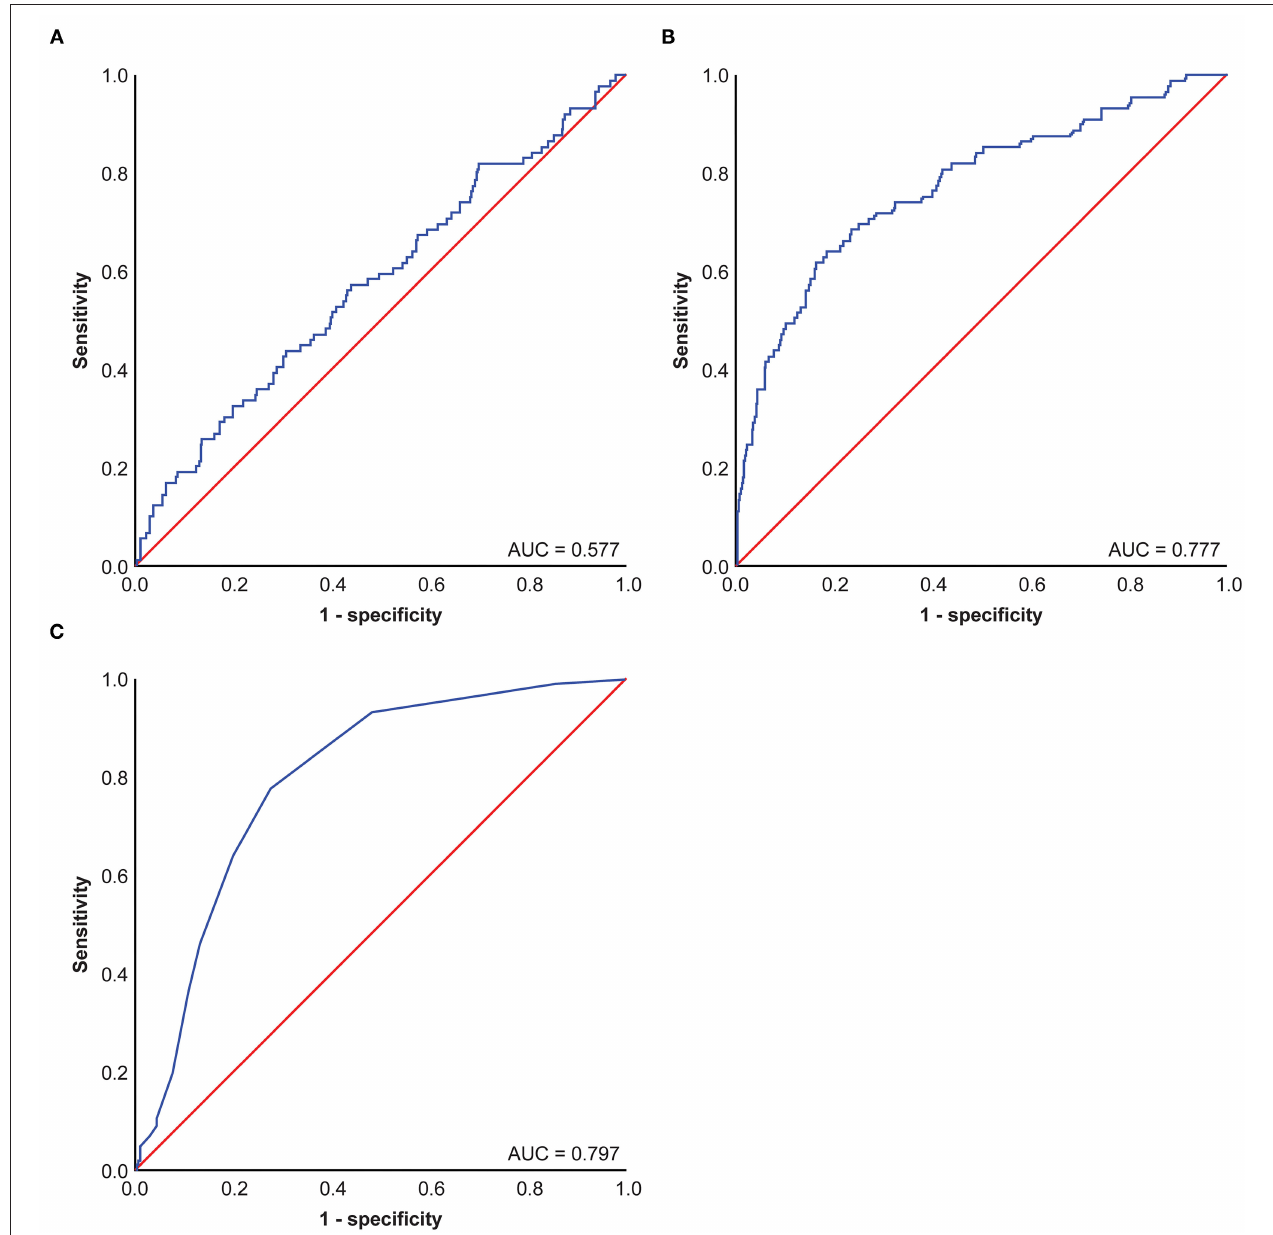
FIGURE 1 | Receiver operating characteristic (ROC) Curve of carcinoembryonic antigen (CEA), KI-67, and age in patients of 650 patients with stage I pulmonary adenocarcinoma. (A) Age ROC Curve of 650 patients with stage I pulmonary adenocarcinoma, (B) CEA ROC Curve of 650 patients with stage I pulmonary adenocarcinoma, (C) KI-67 ROC Curve of 650 patients with stage I pulmonary